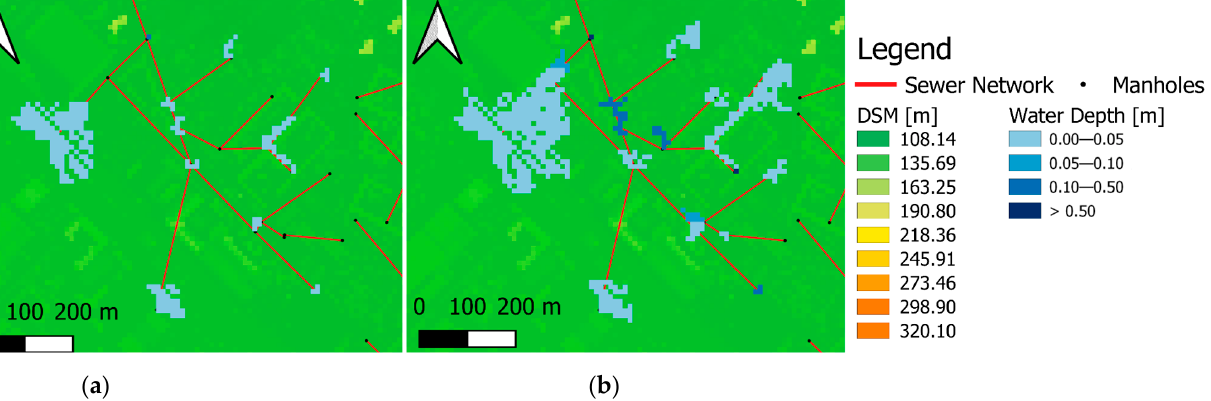
Figure 6. Overland diffusion for a design storm event with a 50-year return period flood in GAMA in study case area. ( a ) Flood propagation 30 min after the start of rain event; ( b ) Flood propagation 180 min after the rain event started.